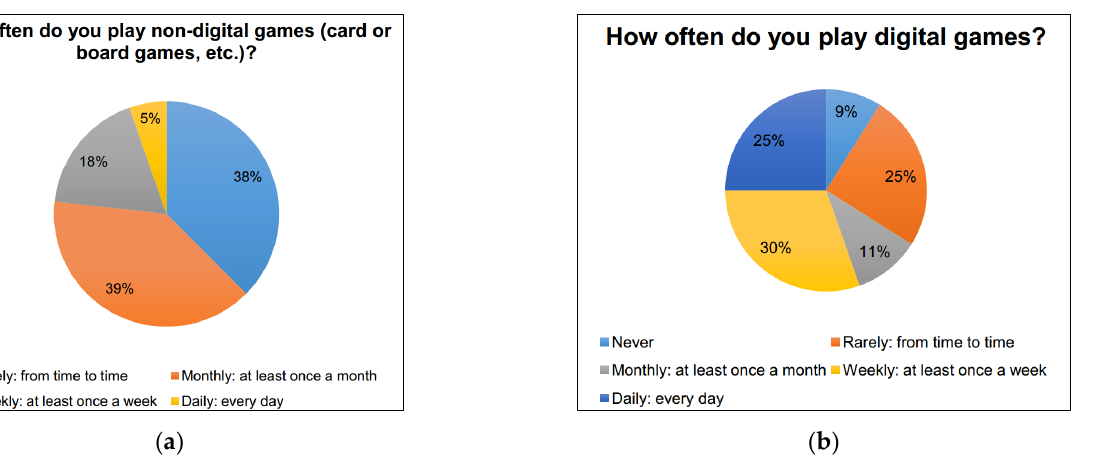
Figure 3. ( a ) Students’ non-digital game habits. ( b ) Students’ digital game habits.